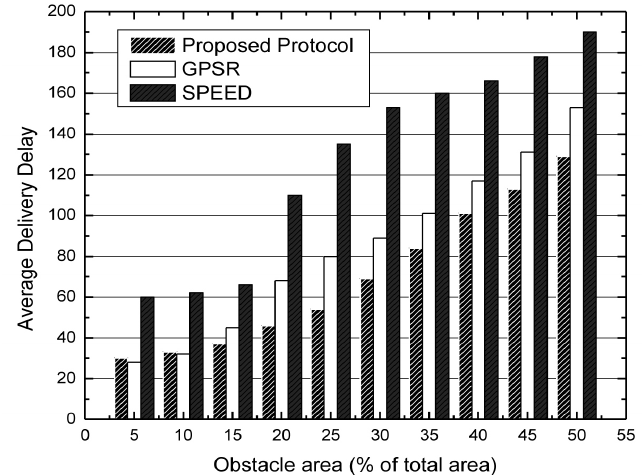
Figure 8. Average delivery delay with expanding obstacle